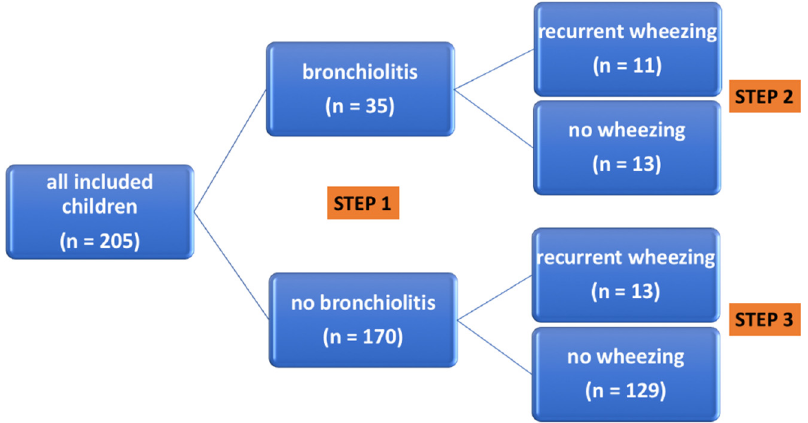
Figure 2. The three different steps in the analysis of our cohort of health neonates. Recurrent wheezing = at least 3 episodes of pediatrician-diagnosed wheezing. Table 1. Risk factors distribution in children according to the development of bronchiolitis and post bronchiolitis recurrent wheezing.